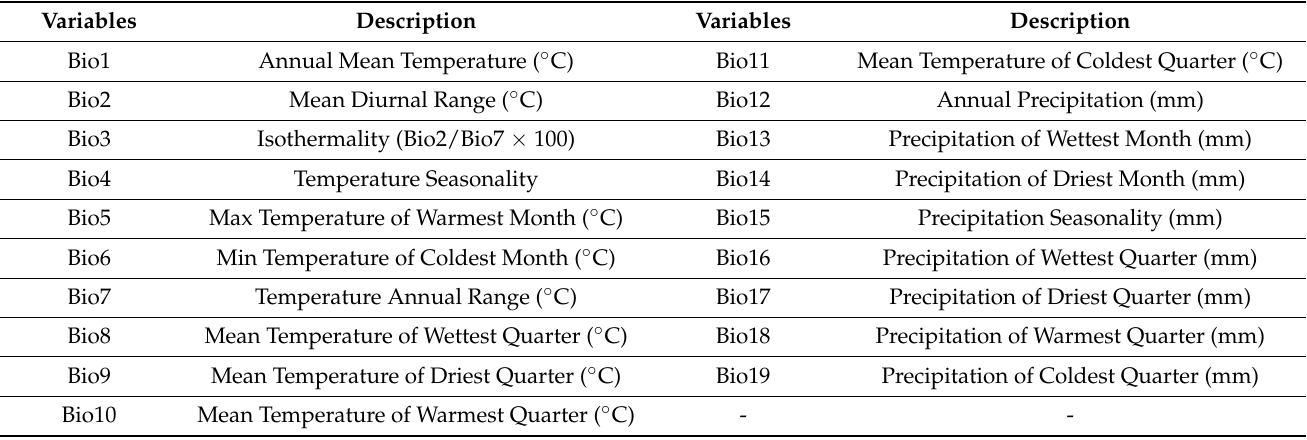
Table 2. Introduction to the 19 BIOCLIM climate